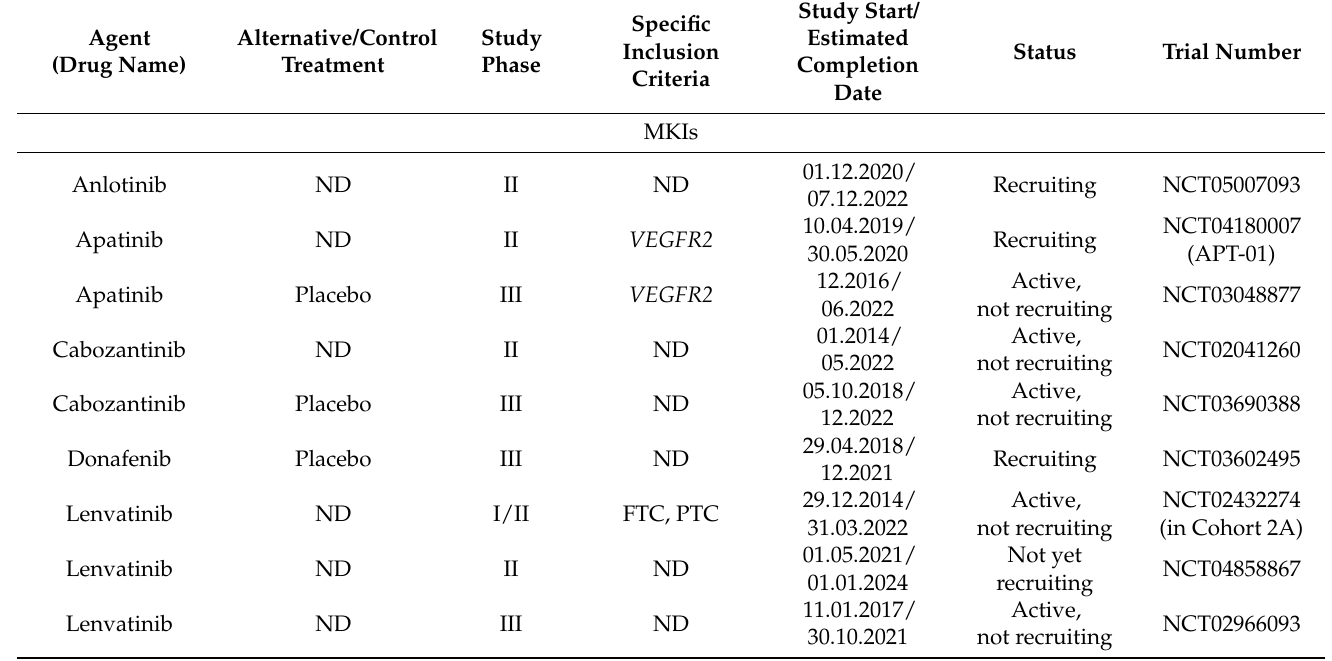
Table 2. Kinase inhibitors currently investigated in clinical trials for DTC treatment (registered under ClinicalTrials.gov and